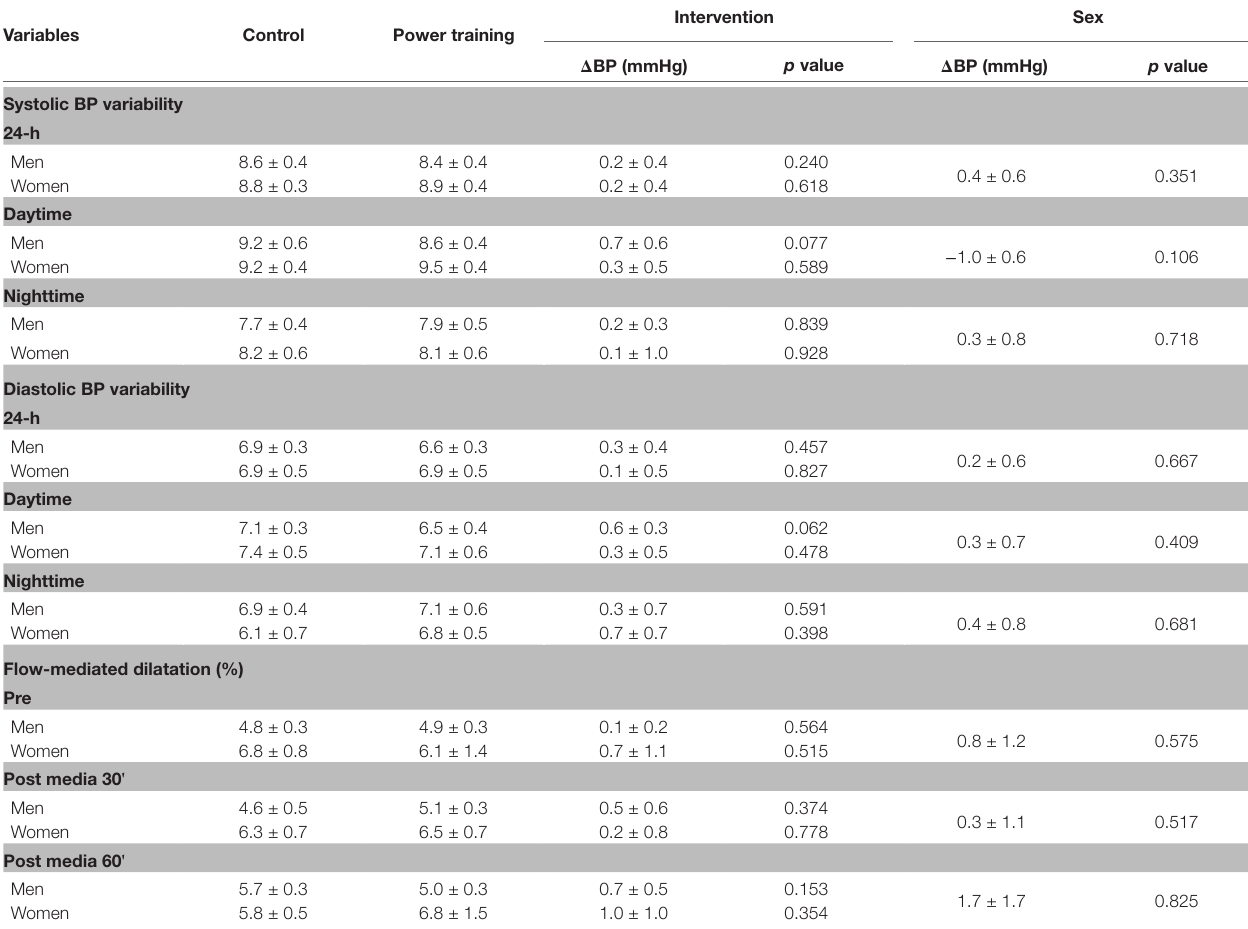
TABLE 5 | Short-term blood pressure variability and endothelial function measures after the power training and control sessions in men and women.